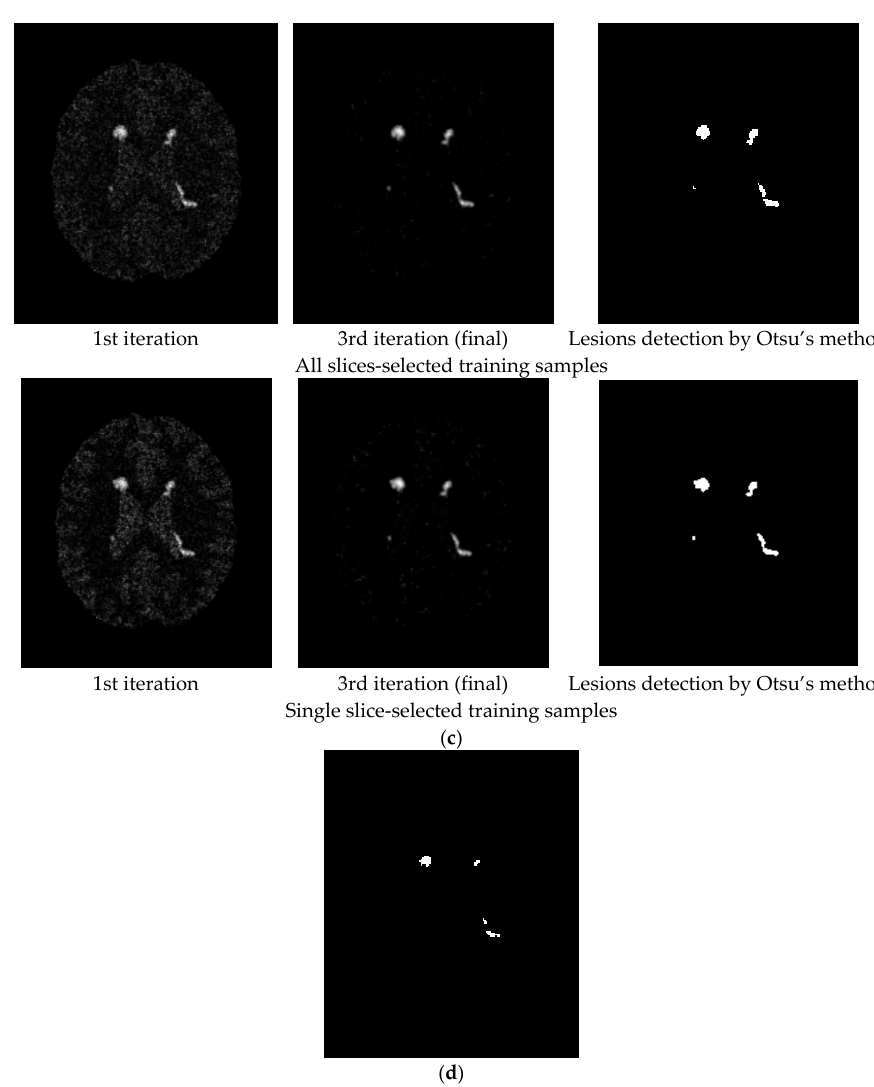
Figure 9. Lesion detection of Slice 97 with 7% noise and 0% INU by CBEP-ICEM1 and CBEP-ICEM2. ( a ) Original 97th slice of MS MR brain images with 7% noise and 0% INU; ( b ) CBEP-ICEM1; ( c ) CBEP-ICEM2; ( d ) Lesion detection LST.